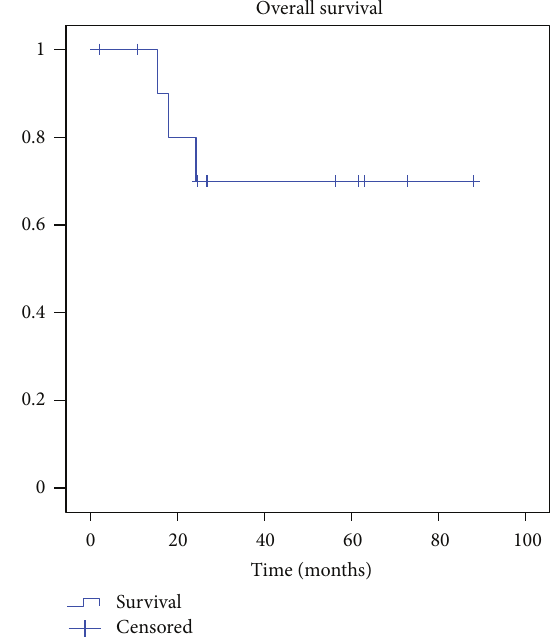
Figure 1: Kaplan-Maier curve for patients’ overall survival rate with death of disease as